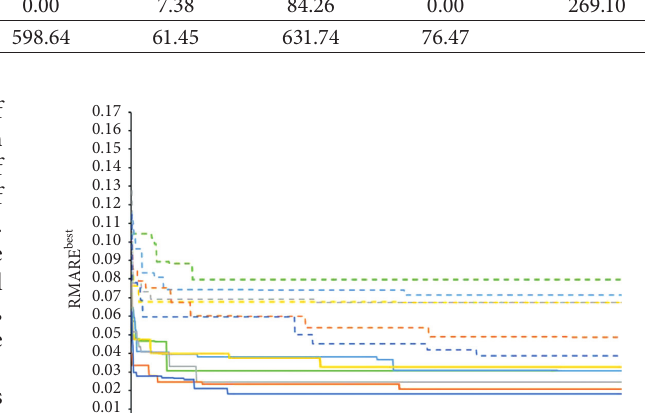
Figure 8: Evolution of the error RMARE best with the number of iterations made, considering different values of F without (W/O) the proposed